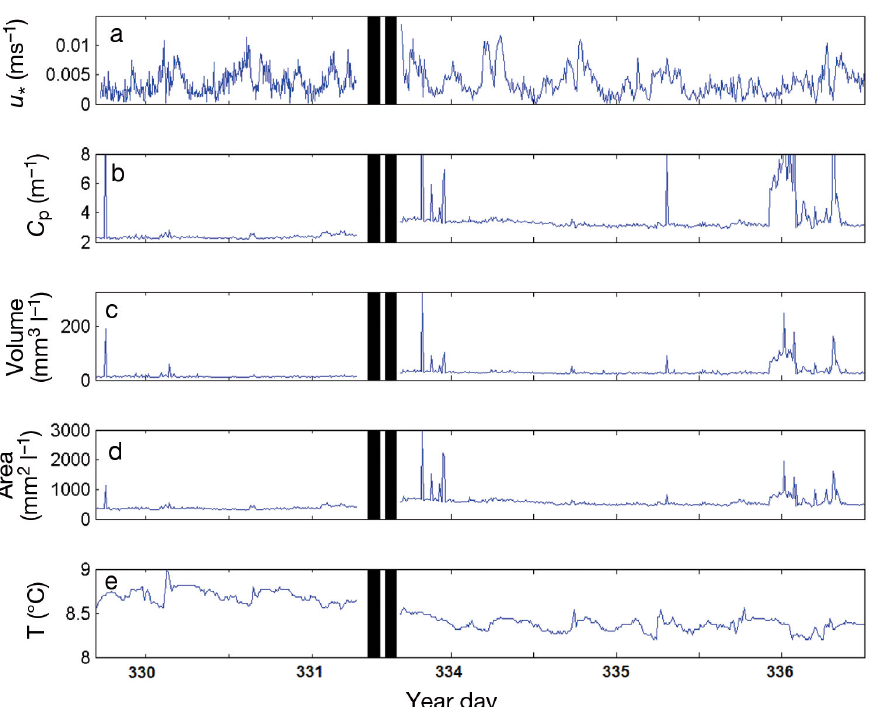
Fig. 7. (a) Shear velocity ( u *) calculated over the study period (deployment 1, left; deployment 2, right) using the law of the wall and a bottom roughness parameter of 2.0 × 10 –4 from Soulsby (1983) for a muddy seabed; the next 4 panels show (b) beam attenuation ( C p ), (c) volume concentration, (d) area concentration and (e) water temperature, all collected by the LISST over the study